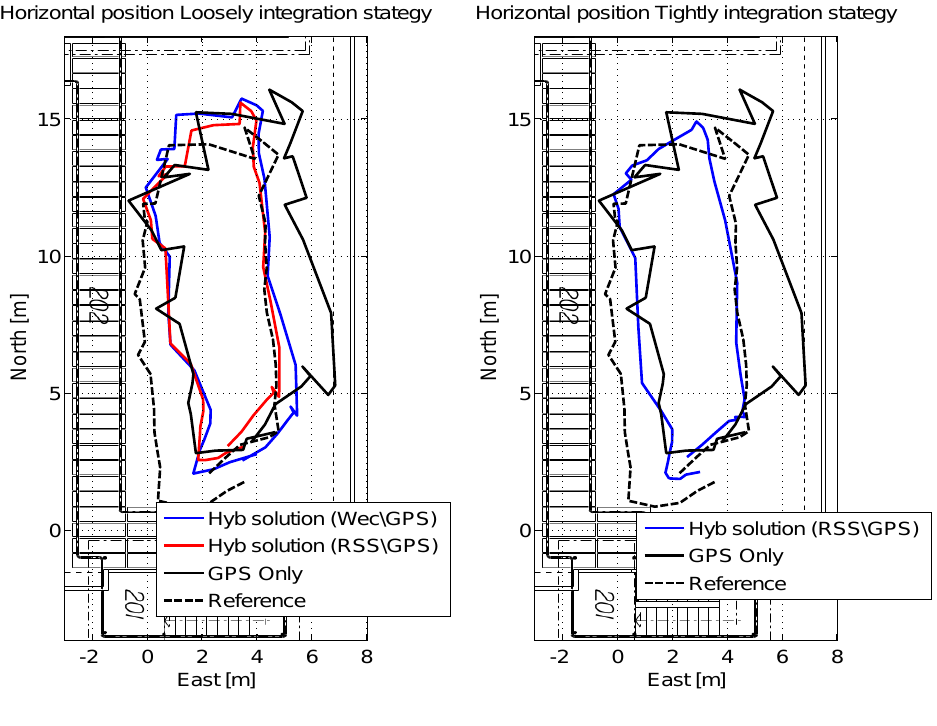
Figure 19. Trajectories obtained using hybrid integration strategies in the outdoor scenario. A single lap is provided for clarity.